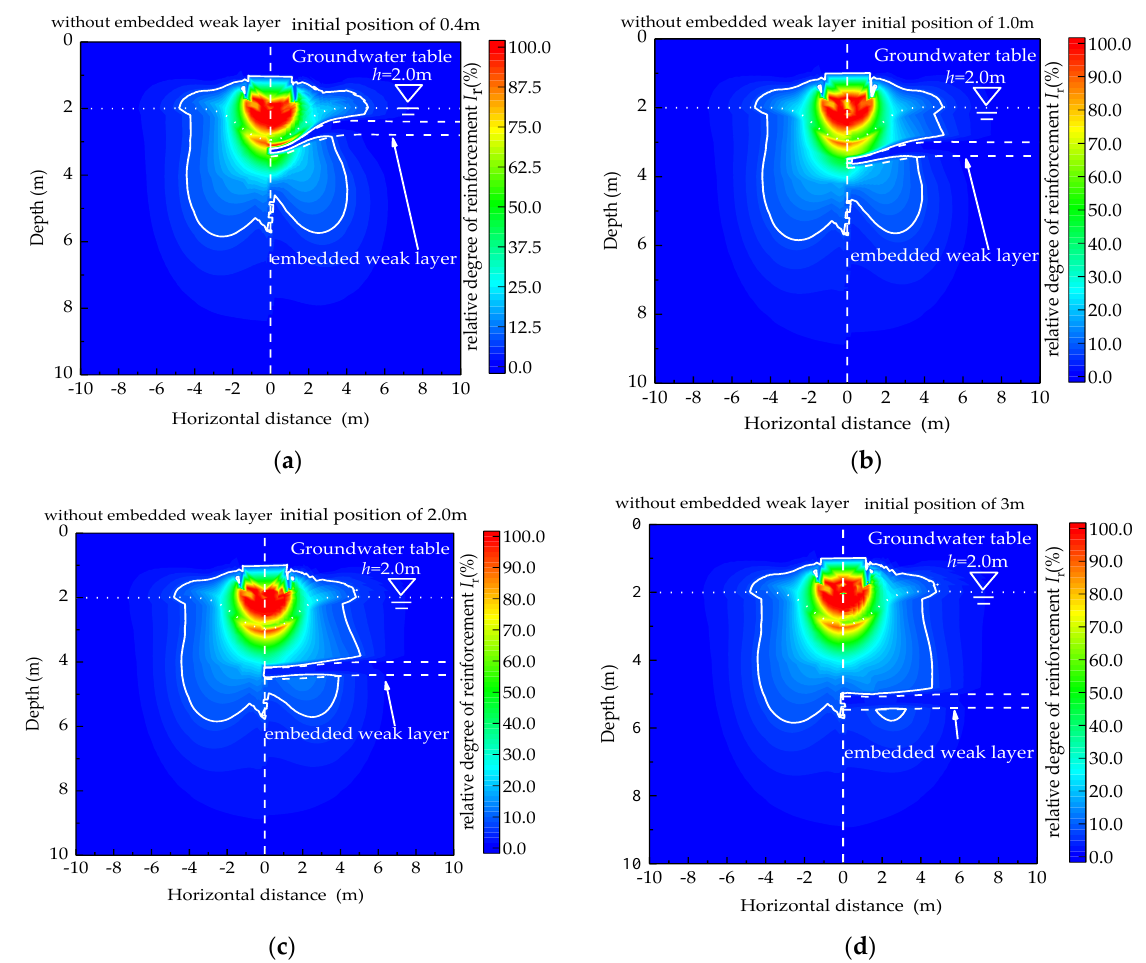
( d ) Figure 12. Distributions of excess pore water pressure ratio in grounds with embedded weak layers of different thicknesses. ( a ) 0.4 m; ( b ) 1 m; ( c ) 1.6 m; ( d ) 2.0 m. 4.2.2. Influences of Depth of the Embedded Weak Layer In the numerical simulations, the depth of the embedded weak layer ranged from 0.4 to 3.0 m to investigate its influences on the improvement effect of DC to the saturated ground. The left half of each figure presents the ground without a weak layer, while the right half represents the ground with an embedded weak layer (see cases 5 to 8 in Table 4).